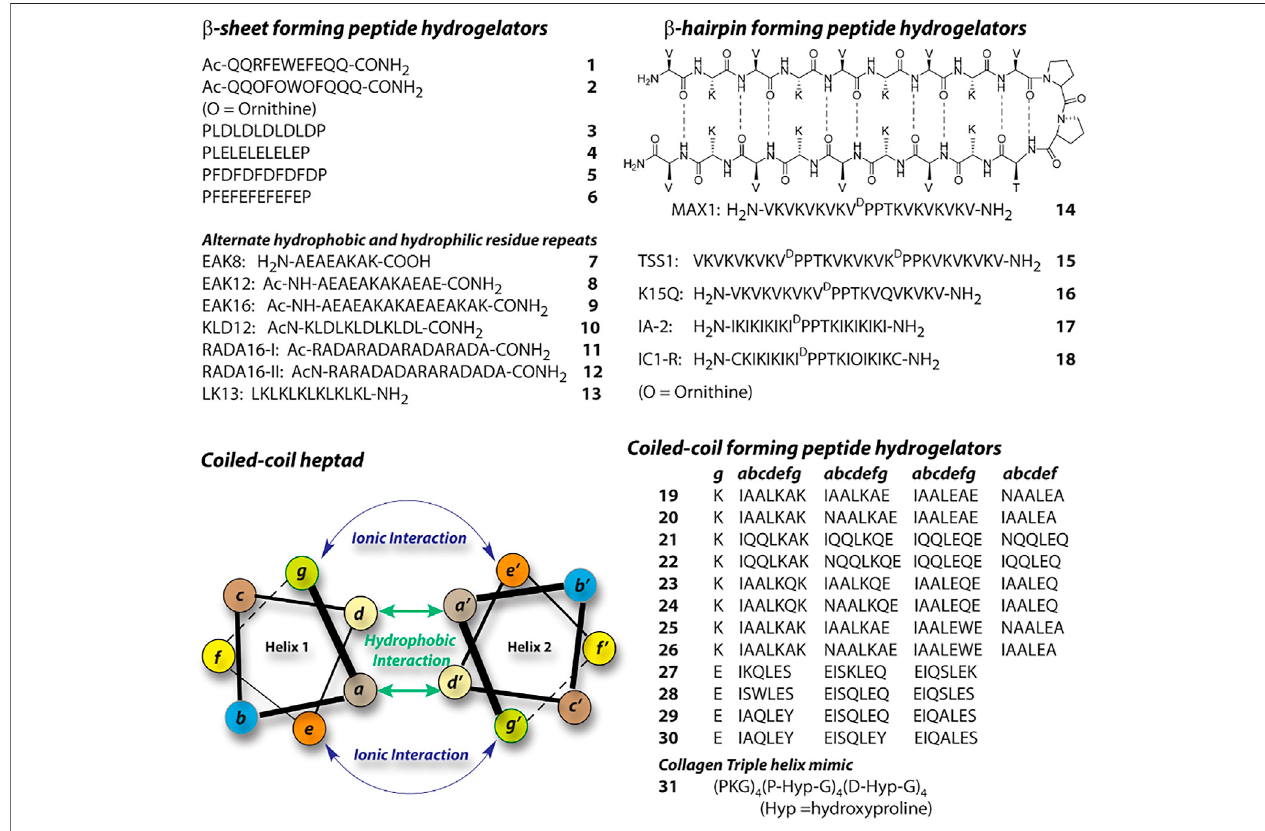
FIGURE 2 | Sequences of representative peptide-hydrogelators classi fi ed according to the secondary structures.